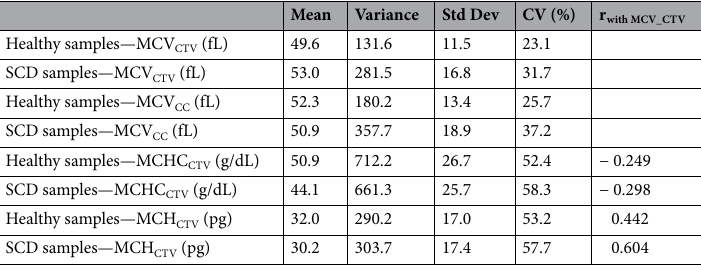
Table 2. Average, variance, standard deviation, coefficient of variation (CV) and Pearson’s correlation coefficients (r) with MCV CTV of several iron status parameters for all tracked healthy and sickle RBCs.